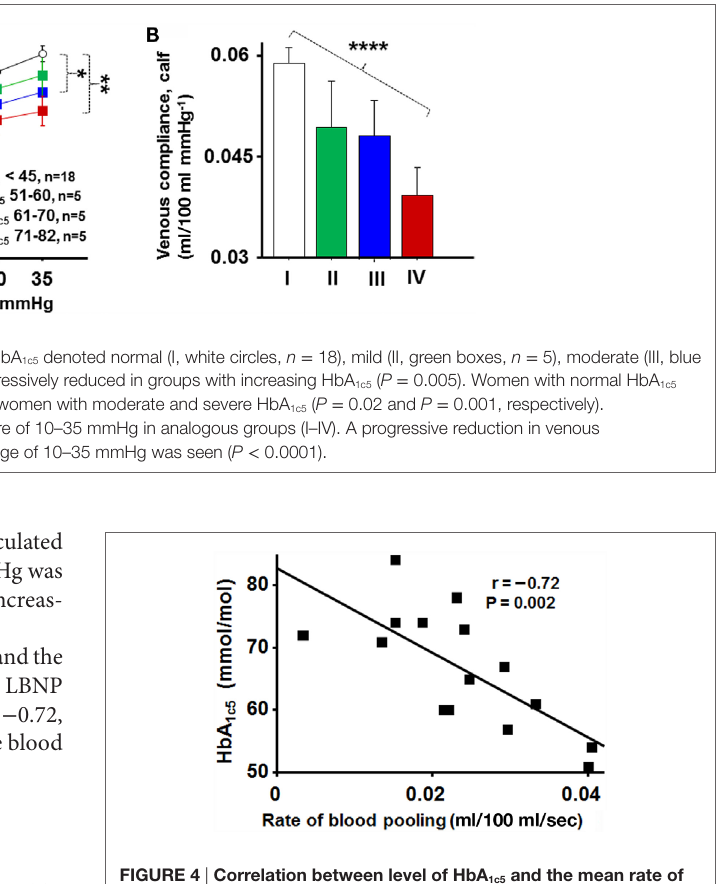
FigUre 4 | correlation between level of hba 1c5 and the mean rate of calf volume increase 30–60 s after lBnP initiation in DW . A negative correlation seen ( r = − 0.72, P = 0.002), i.e., slower increase in blood volume with worse glycemic control.